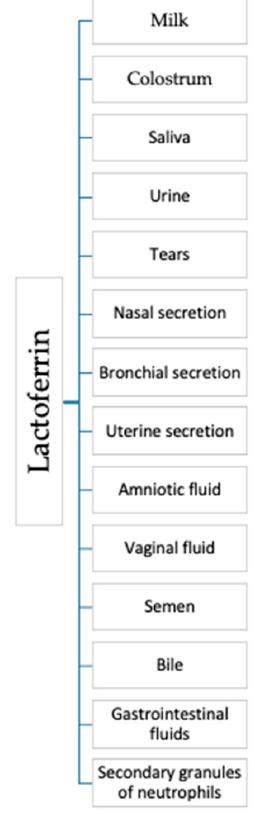
Figure 1. Sources of lactoferrin.